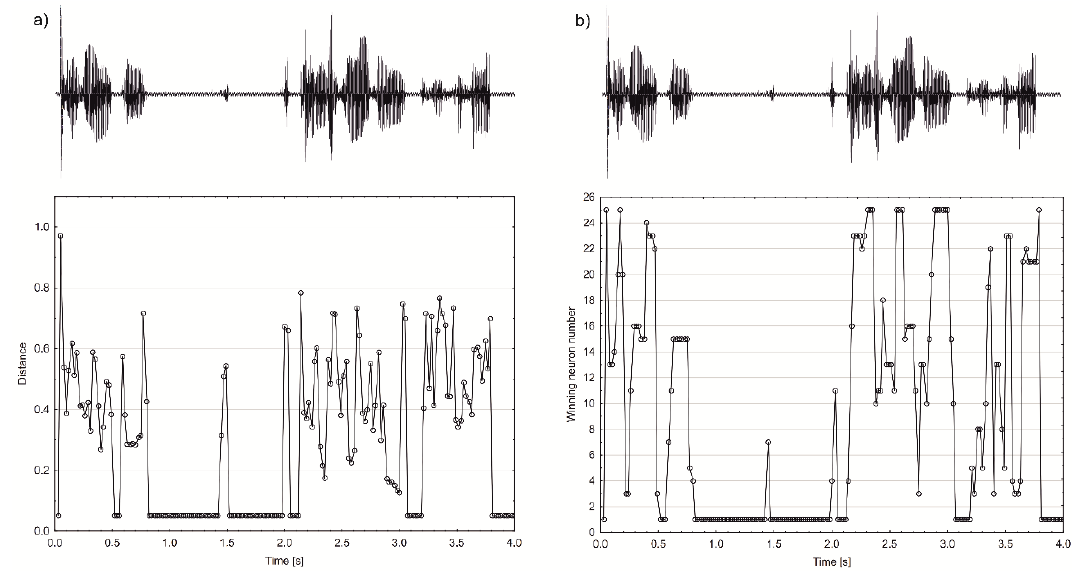
Figure 8. The representation of sound repetition with the PCA ( a ) and Kohonen ( b ) algorithm application.